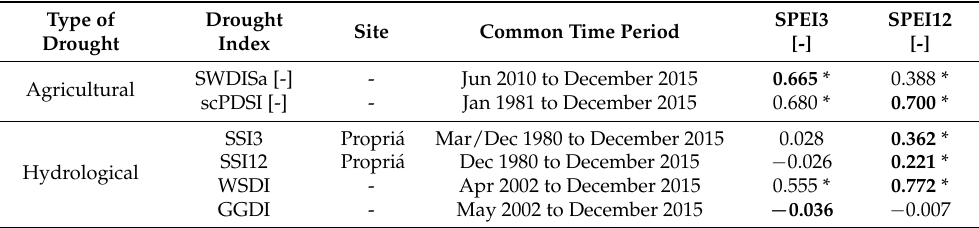
Table 4. Spearman rank correlation coefficients between the SPEI3 and SPEI12 and the SWDISa, scPDSI, SSI, WSDI, and GGDI in the SFRB during their common time periods 1 . Type of Drought Site Drought Index